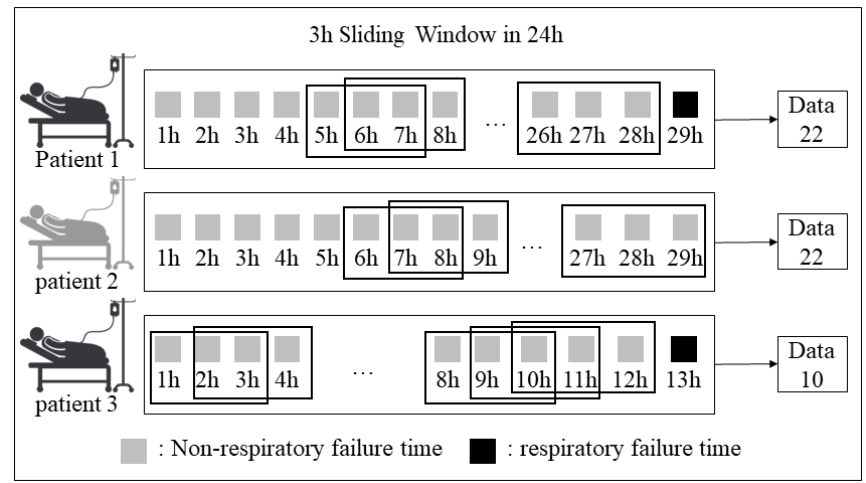
Figure 4. Processing by sliding window.